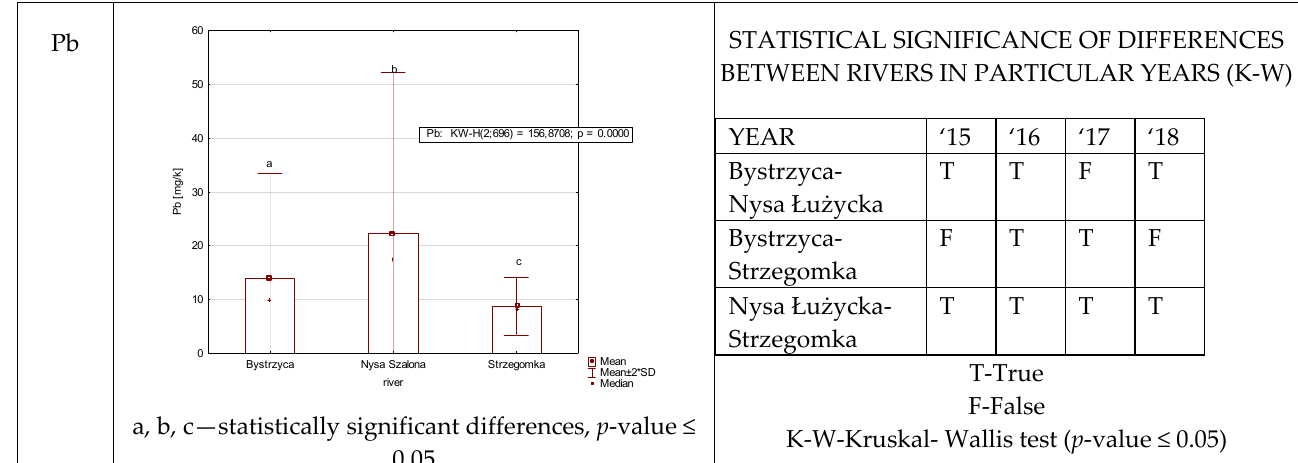
found only between the Bystrzyca and the Nysa Szalona, and between the Nysa Szalona and the Strzegomka. The multiannual data collected allowed for the observation of the lowest amount of lead in the Strzegomka and the highest in the Nysa Szalona.